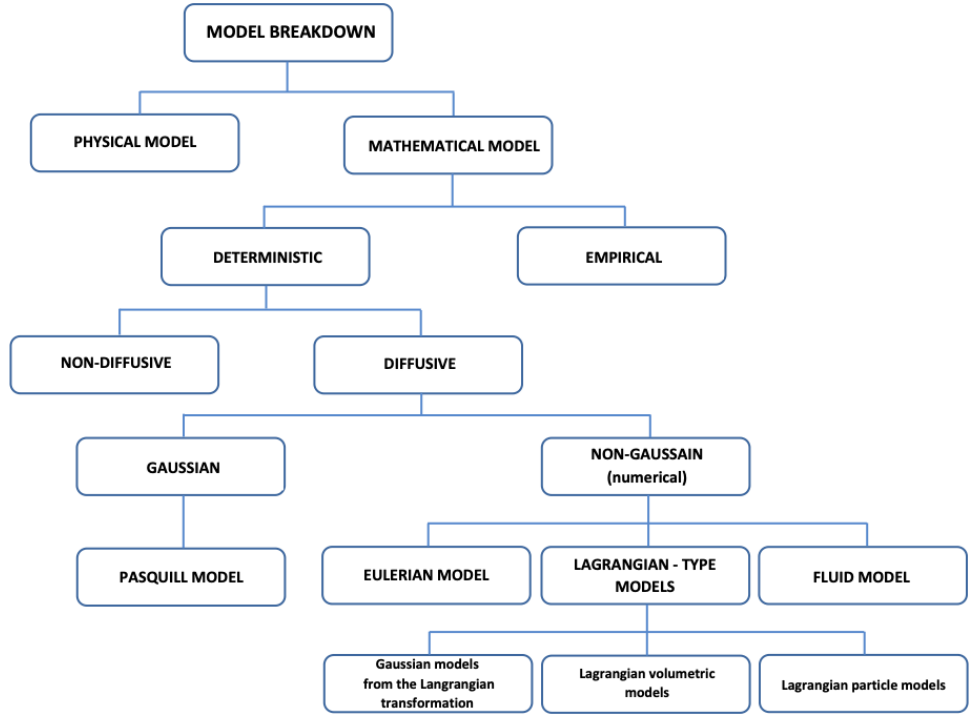
Figure 1. Classification of models of pollutant dispersion in atmospheric air (own work, based upon